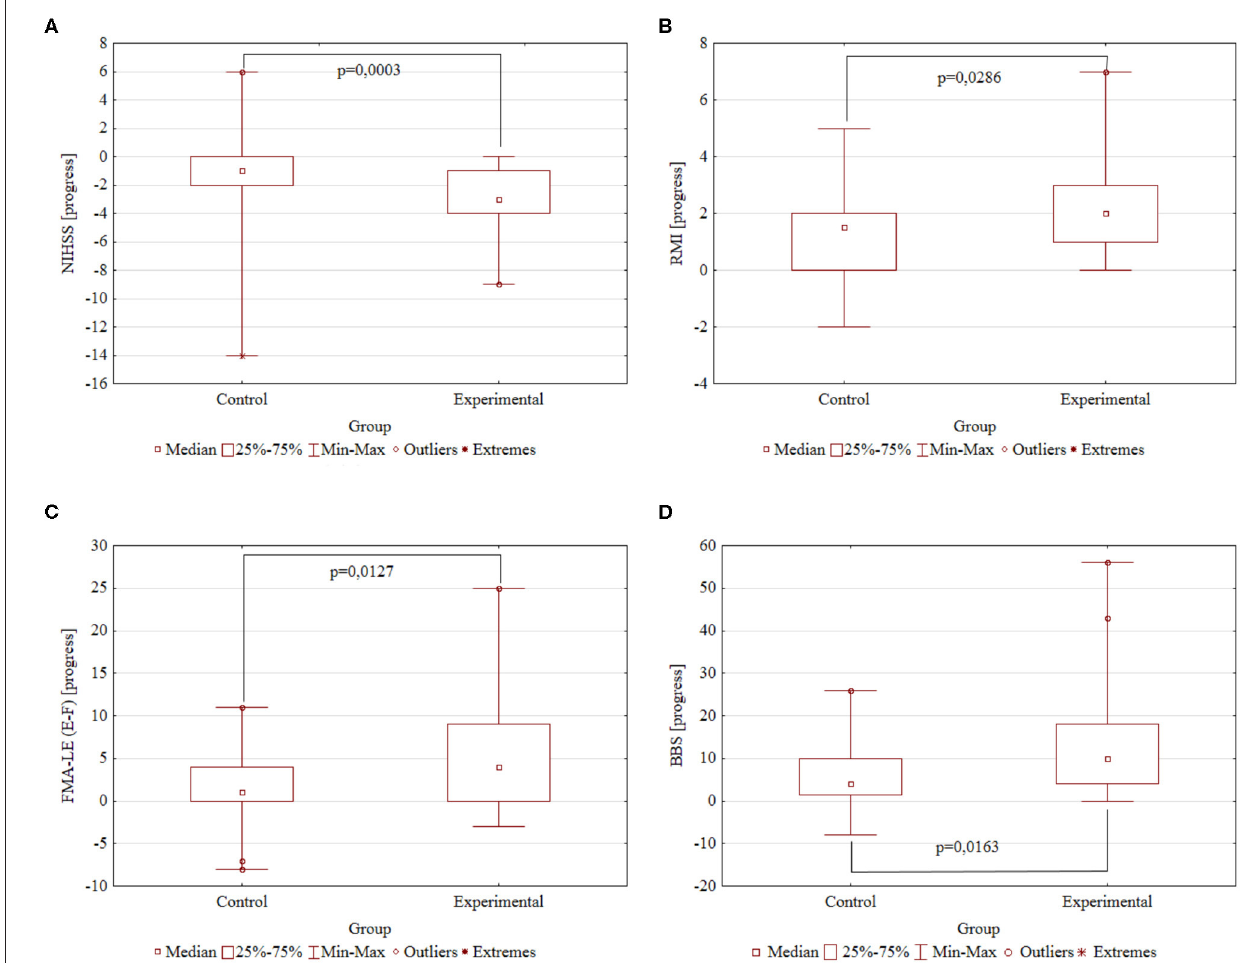
FIGURE 2 | The rehabilitation progresses. Comparison of the Control ( N = 27) and Experimental ( N = 35) groups by the study scales. The difference in scores after and before rehabilitation. P -value obtained by two-tailed Mann–Whitney U test. (A) NIHSS progress. (B) RMI progress. (C) FMA-LE progress. (D) BBS